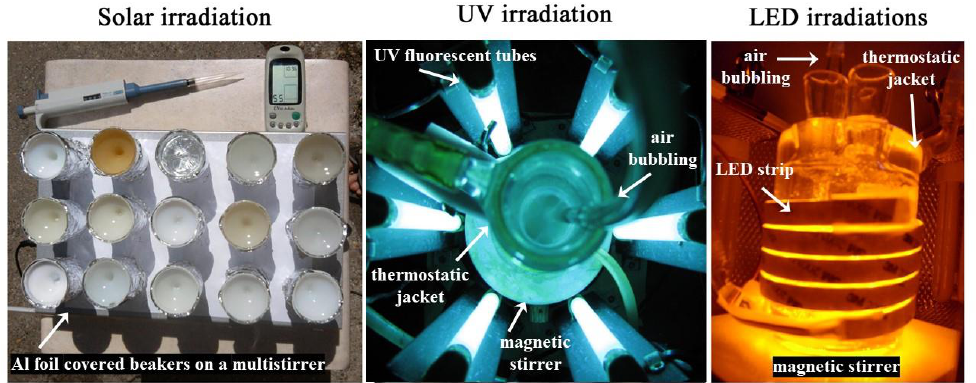
Figure 4. Applied photoreactor systems (for solar experiments, the beakers were surrounded by aluminum foil to ensure that photocatalysts were irradiated by sunlight only from the top of the beakers, which did not overshadow each